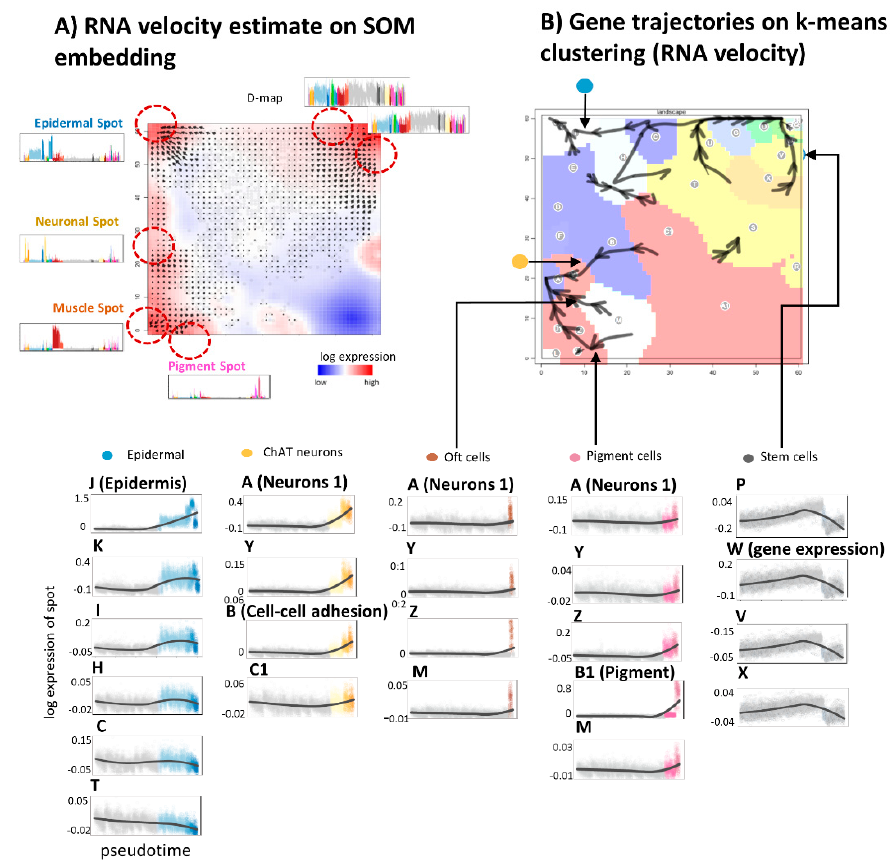
Figure 6. RNA velocity portrayal: ( A ) RNA velocity vector-field with metagene resolution identifies overexpression spot modules as attractors of overexpression except the “kernel” metagenes in the center of each spot (see text). ( B ) Velocity-trajectories using SOM area-segmentation indicate “watersheds” of differentiation between the attractors. The expression profiles illustrate expression changes along the selected trajectories.